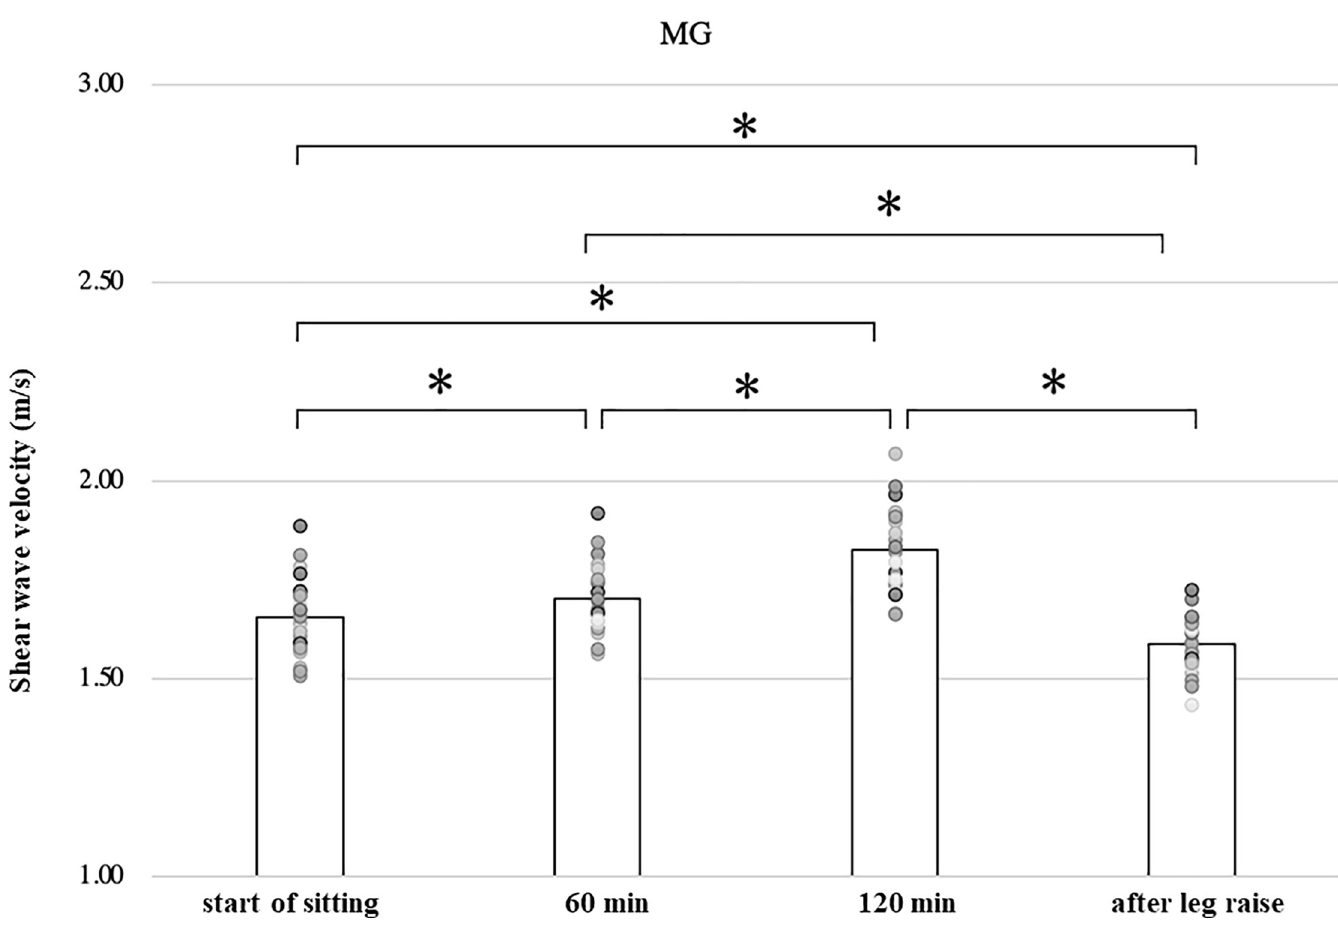
Fig 6. Shear wave velocity of the medial